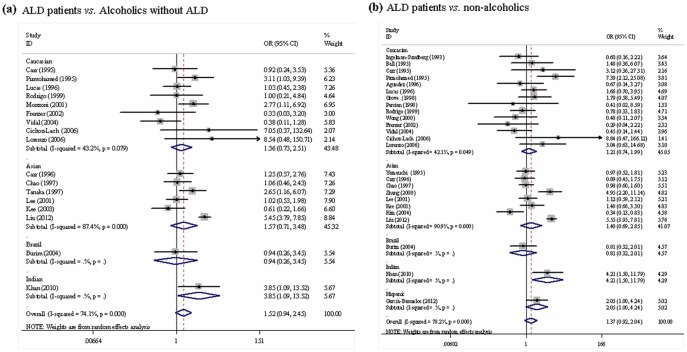
Meta-analysis for CYP2E1 Pst I/Rsa I polymorphism and the risk of ALD (allele c2 vs. c1).(a) ALD patients vs. alcoholics without ALD; (b) ALD patients vs. non-alcoholics. Each study was shown by a point estimate of the effect size (OR) (size inversely proportional to its variance) and its 95% confidence interval (95%CI) (horizontal lines). The white diamond denotes the pooled OR.